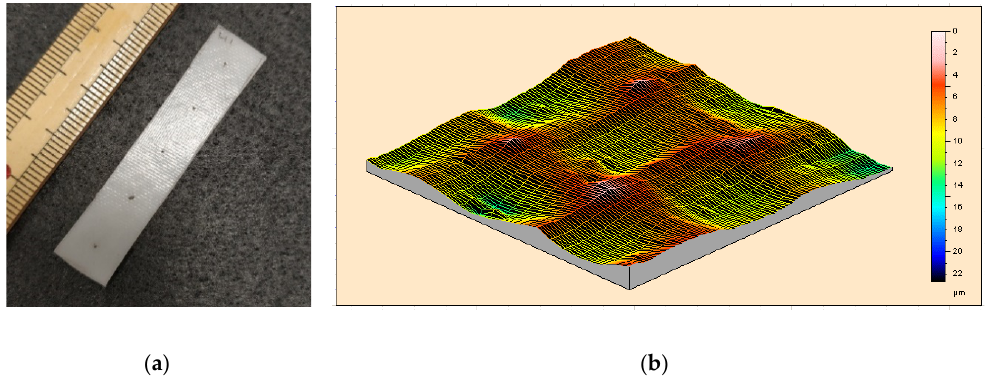
Figure 3. Typical strip-shaped 1-mm thick sample prepared by hot-compression ( a ) (standard rule is included for reference) and 3D surface morphology ( b ) (scanned area: 1 mm × 1 mm, the unit for the scale bar is μm).